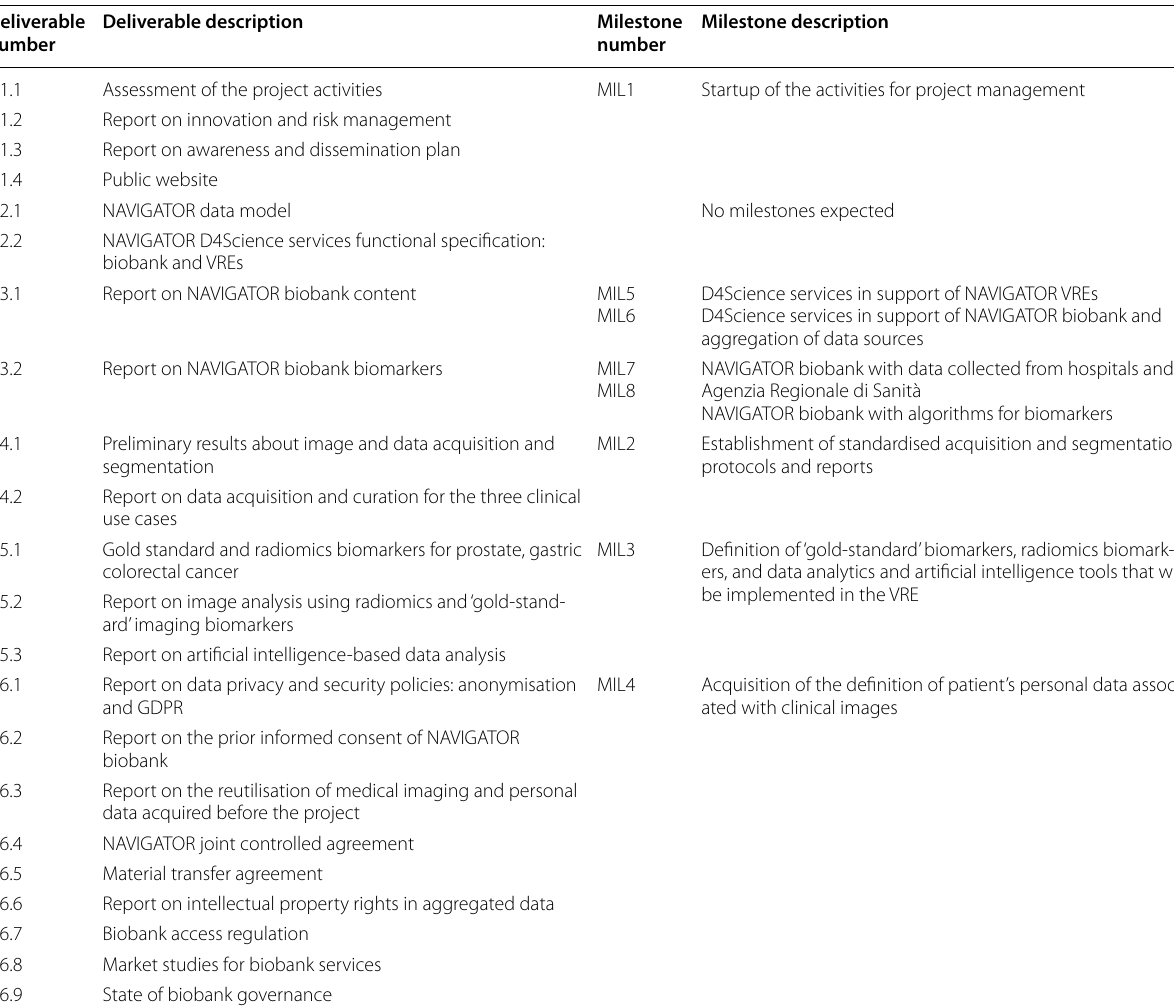
Table 1 The main deliverables and milestones of the NAVIGATOR project